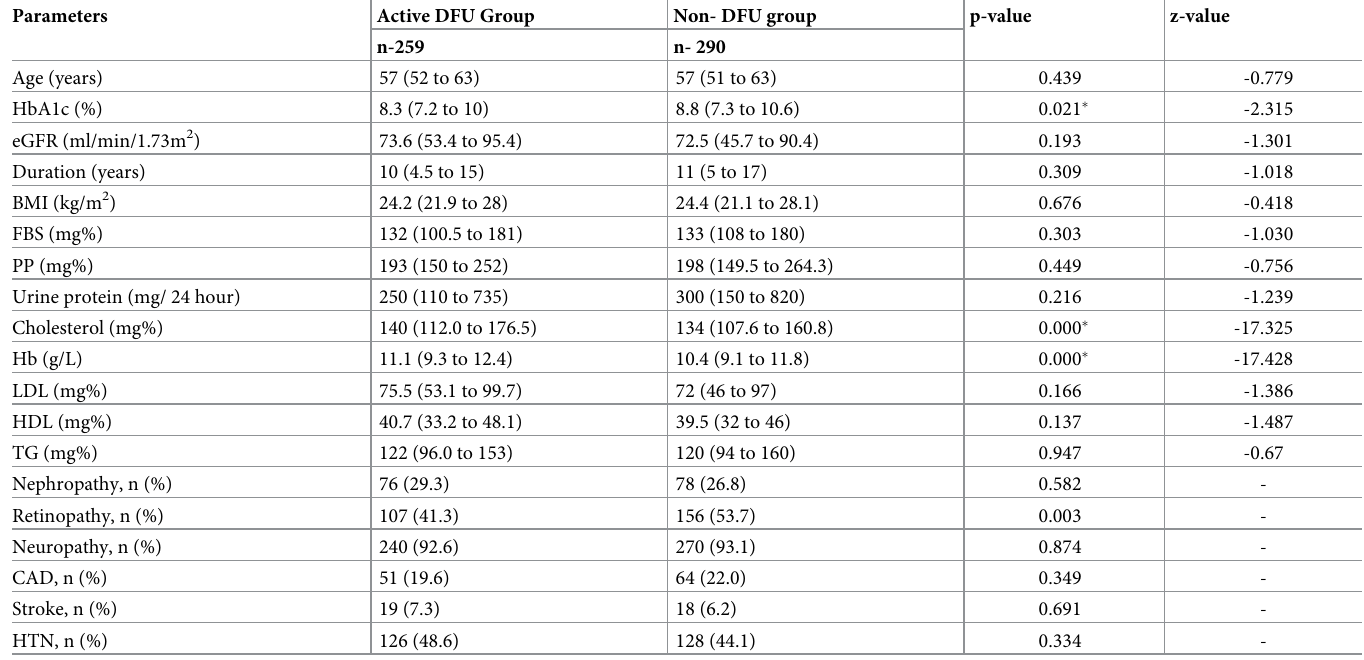
Data represented as median (inter-quartile range) unless specified and two group comparison was performed by Mann-Whitney test. Categorical variable are represented as n (%) and intergroup comparison was performed by Chi-square test. �